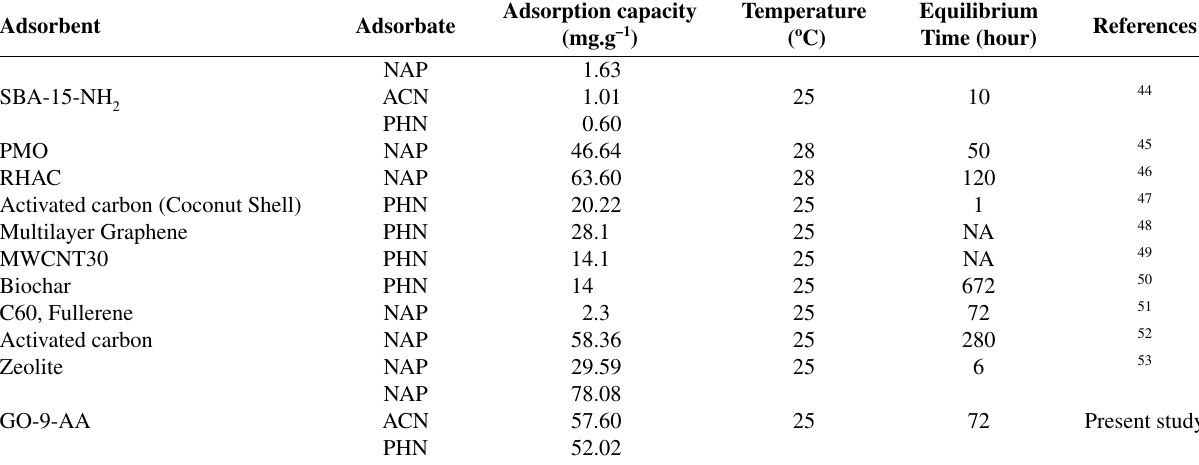
Table 4. Comparison of maximum adsorption capacity of different adsorbents for adsorption of PAHs